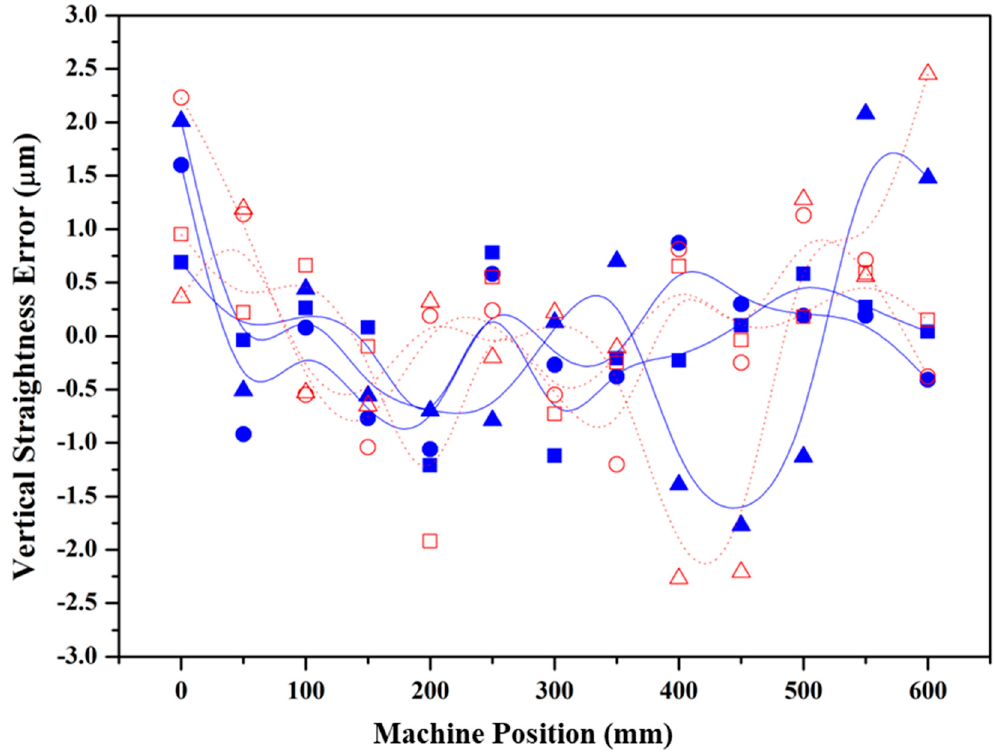
Figure 12. Vertical straightness errors of single-axis measurement verification: ■▲● —laser interferometer, and □ △〇 —proposed system.